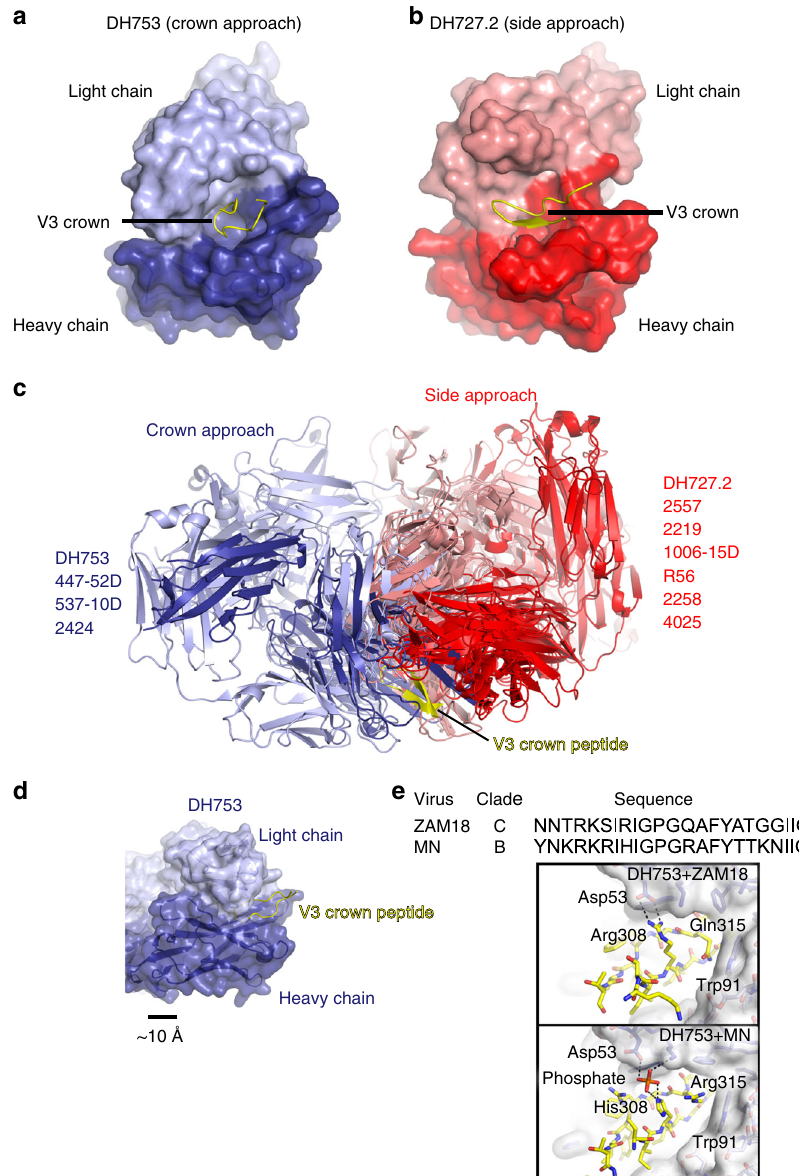
Fig. 5 Structural analysis of macaque V3 antibodies. a The crystal structure of DH753 is shown with the L chain rendered in lilac, the FabH chain in dark purple, and bound ZAM18 V3 hairpin peptide in yellow. b The crystal structure of DH727.2 is shown in a similar orientation with the L chain in salmon, the FabH chain in red, and the ZAM18 V3 peptide again in yellow. c A superposition of several V3 antibody-peptide structures on the basis of the peptide (yellow) showed two clusterings. The ‘ crown approach ’ cluster included DH753 and other antibodies depicted in purple shades. The ‘ side approach ’ cluster included DH727.2 and other antibodies depicted in red shades. d DH753 bound the V3 hairpin head-on by virtue of a deep pocket in its paratope. e Structures of DH753 with two different V3 peptides were determined in order to scrutinize requirements for interaction. Some conservative mutations are tolerated in the antibody-antigen interface. For instance, mutation of the long Arg308 side chain to the shorter His became a through-interaction mediated by a phosphate